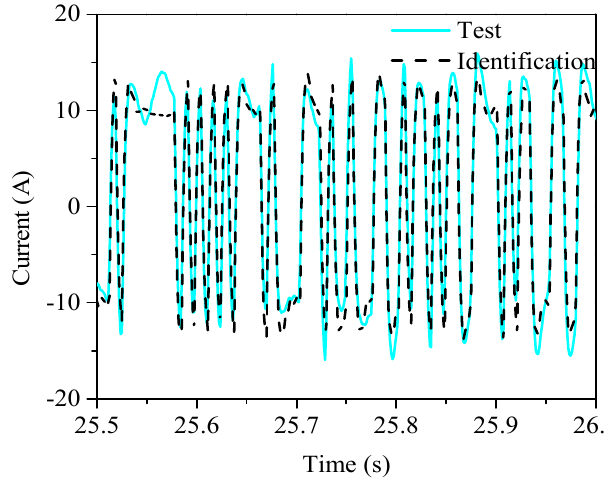
Figure 13. Verification of the identification model.